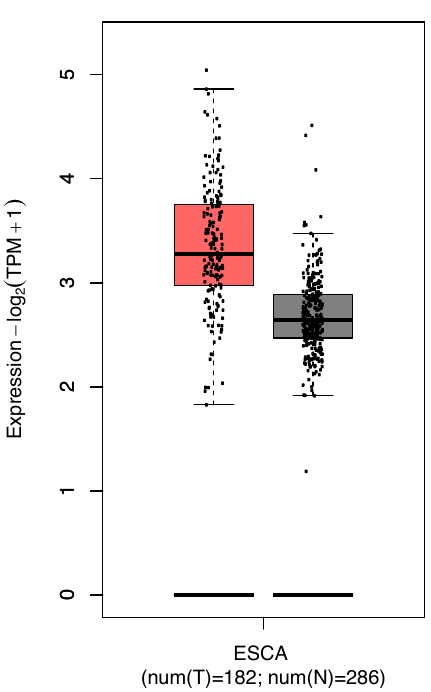
Figure 1: Flow diagram.